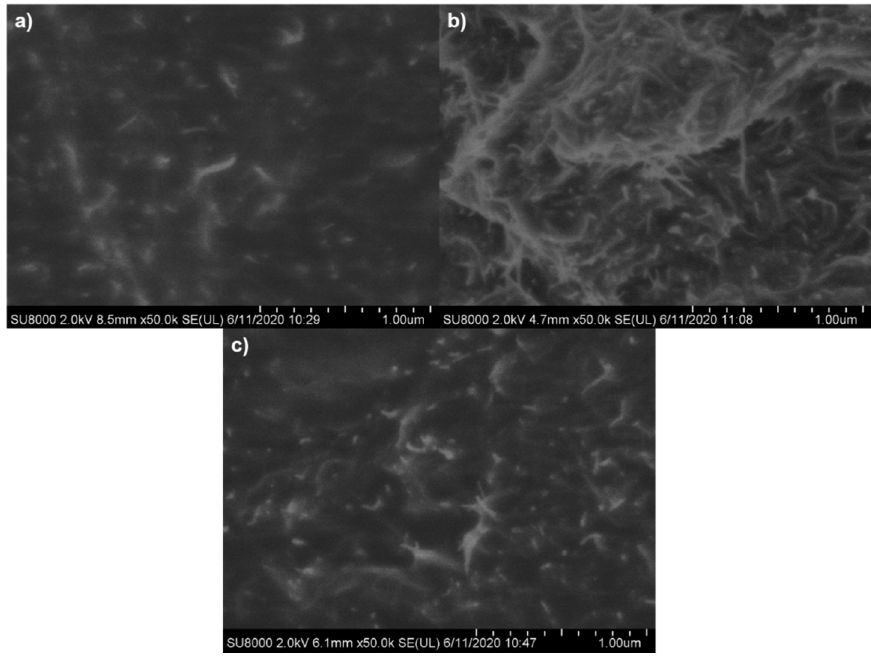
Figure 8. Scanning electron microscopy (SEM) images of the compounds ( a ) NR-10CNT, ( b ) NR- 10CCNT, and ( c ) NR-10TCNT .